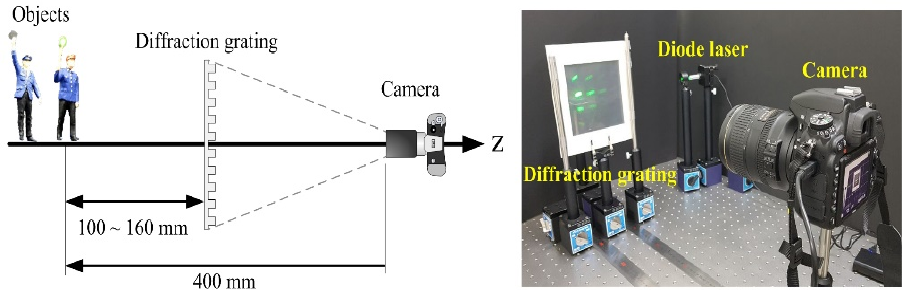
Figure 5. Experimental setup for our pickup process in diffraction grating imaging. The distance between the camera and the closest object is fixed at 400 mm.